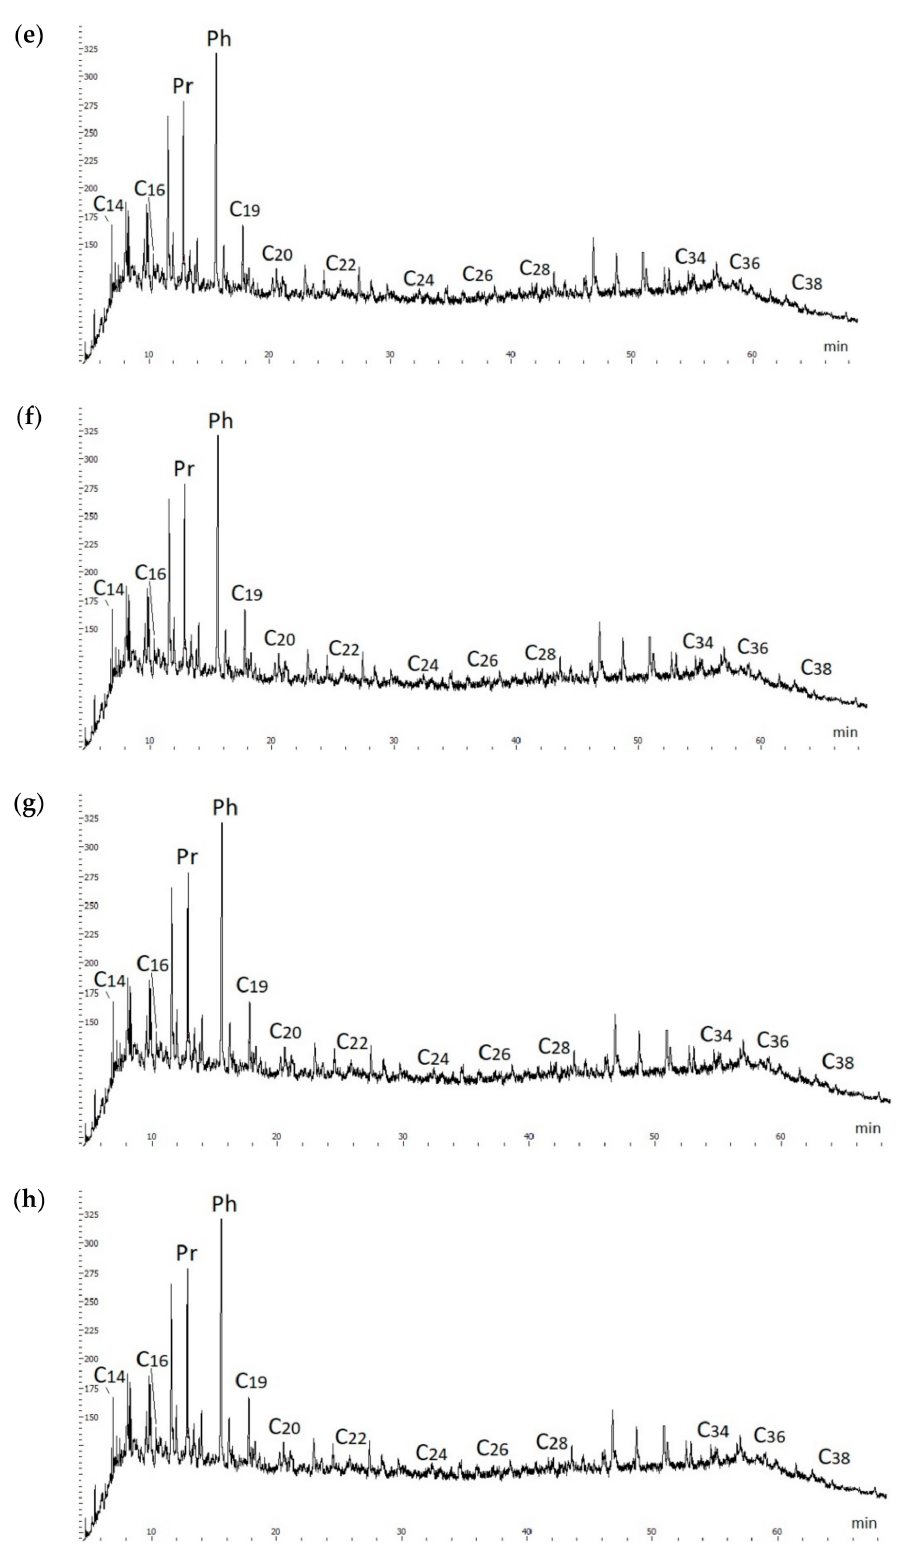
Figure 4. Chromatograms of paraffin-naphthenic and aromatic hydrocarbons of ( a ) the initial oil and converted oil during experiments: ( b ) 1; ( c ) 2; ( d ) 3; ( e ) 4; ( f ) 5; ( g ) 6; ( h )